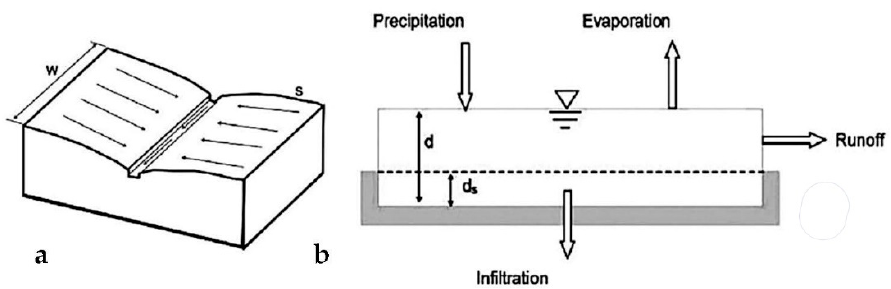
Figure 3. Design storm for a return period of 25 years and an event duration of 1 h.